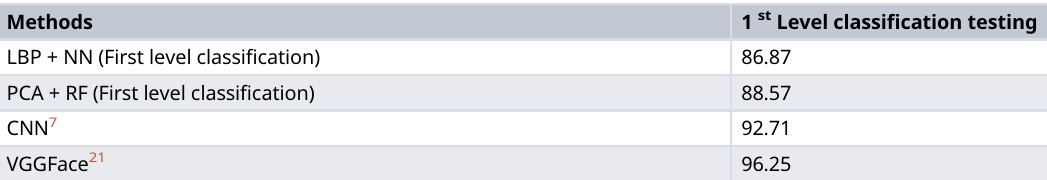
Table 7. A comparison with state-of-the-art methods.